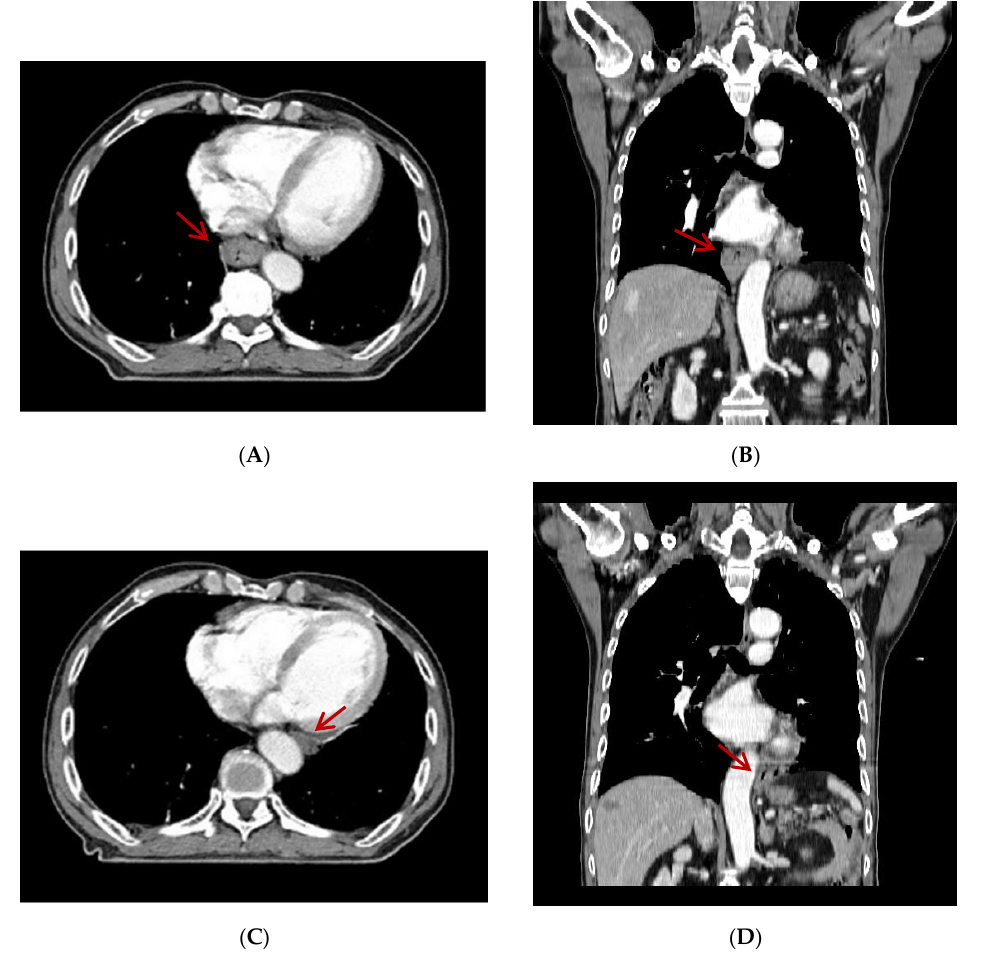
Figure 2. Distal esophageal wall thickening (arrow) was found on axial view ( A ) and coronal view ( B ) of initial computed tomography (CT) scan. Metastatic lymph nodes were not seen on these CT slices. Follow-up computed tomography revealed that the esophagus had moved from the right of the aorta to the left on axial view ( C ) and coronal view ( D ) (arrow). Definitive concurrent chemoradiation was scheduled. The radiation dose was 50.4 Gy/28 fractions over 5.5 weeks. The patient had received continuous infusion of 5-fluor- ouracil (1000 mg/m 2 ) on days 1 through 4 and days 22 through 25 and cisplatin (75 mg/m 2 ) was given on days 1 and 22. By 3 weeks after commencement of chemoradiation, the esophagus was outside of the radiotherapy field during image-guided radiotherapy. Fol- low-up CT revealed that the esophagus had moved from the right of the aorta to the left (Figure 2C,D). Fusion of the radiation plan and follow-up CT showed that prescription dose did not cover the entire esophagus (Figure 3).